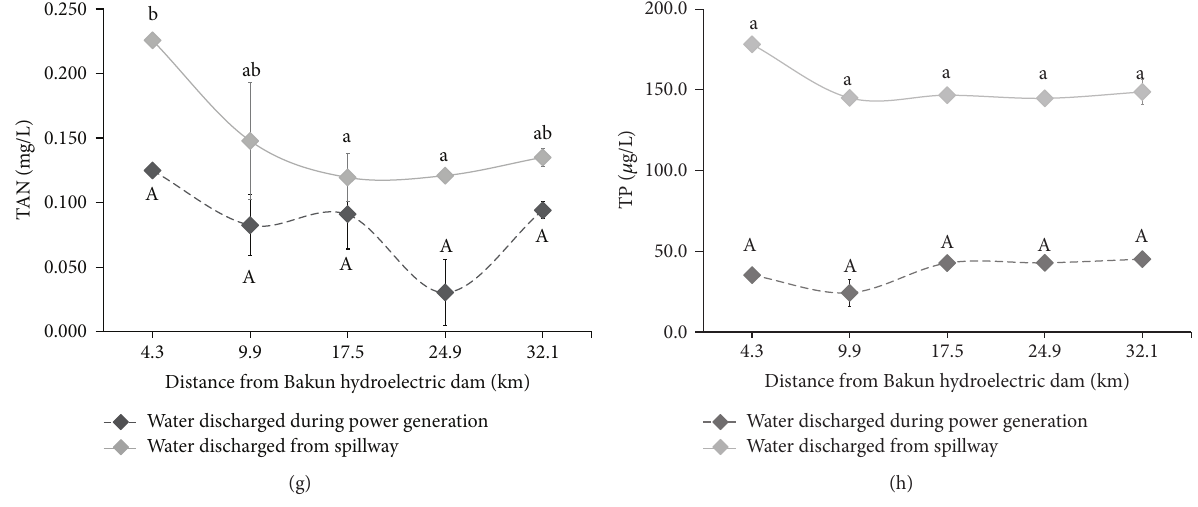
Figure 2: In situ and ex situ water quality parameters of (a) pH, (b) DO, (c), turbidity, (d) TS, (e) BOD 5 , (f) COD, (g), TAN, and (h) TP at stations of downstream Bakun hydroelectric dam when the spillway was closed (dash line) and when it is opened (solid line) when the dam is in operation. Different letters indicate significant difference at 𝑝 value ≤ 0.05 along the downstream river (uppercase—spillway closed; lowercase—spillway